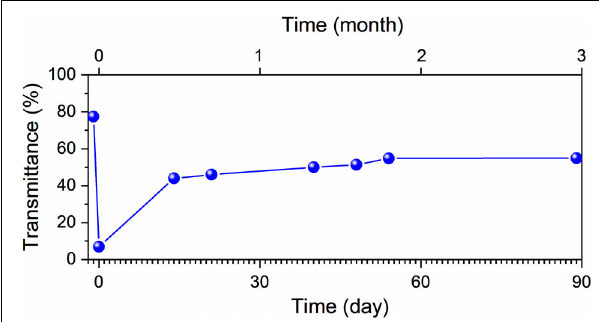
FIGURE 6 | Optical memory test of the glass/ITO/a-WO